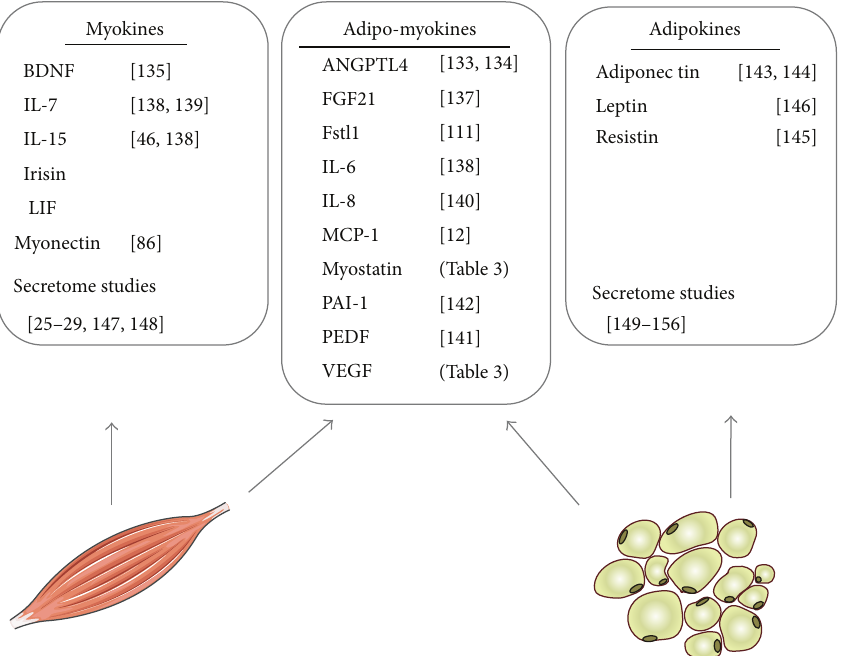
Figure 1: Adipokines, myokines, and adipo-myokines. A search of original articles in pubMed was performed for all myokines described in Table 1 to identify myokines that were also secreted by adipocytes. The search terms used were “adipose tissue,” “adipocyte,” and the indicated cytokine/protein. Reference lists of identified articles were also used to search for further papers. Indicated references published data that the cytokines/proteins are secreted or not secreted by adipocytes or adipose tissue. No data was published on the secretion of LIF and irisin from adipocytes or adipose